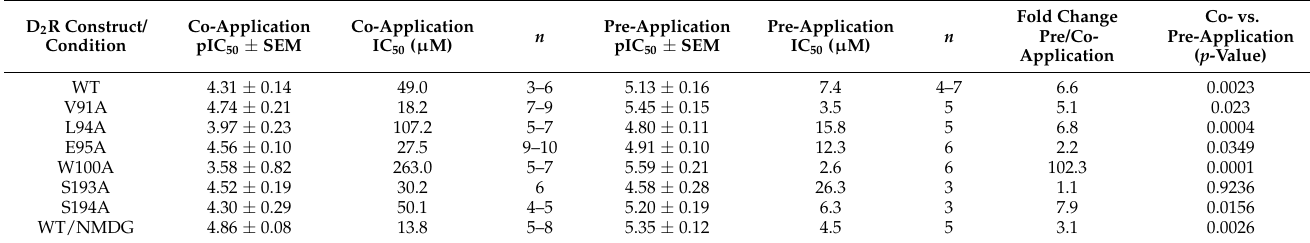
Table 2. SB269,652 potencies at the WT and mutant D 2 R, including the sodium-free condition